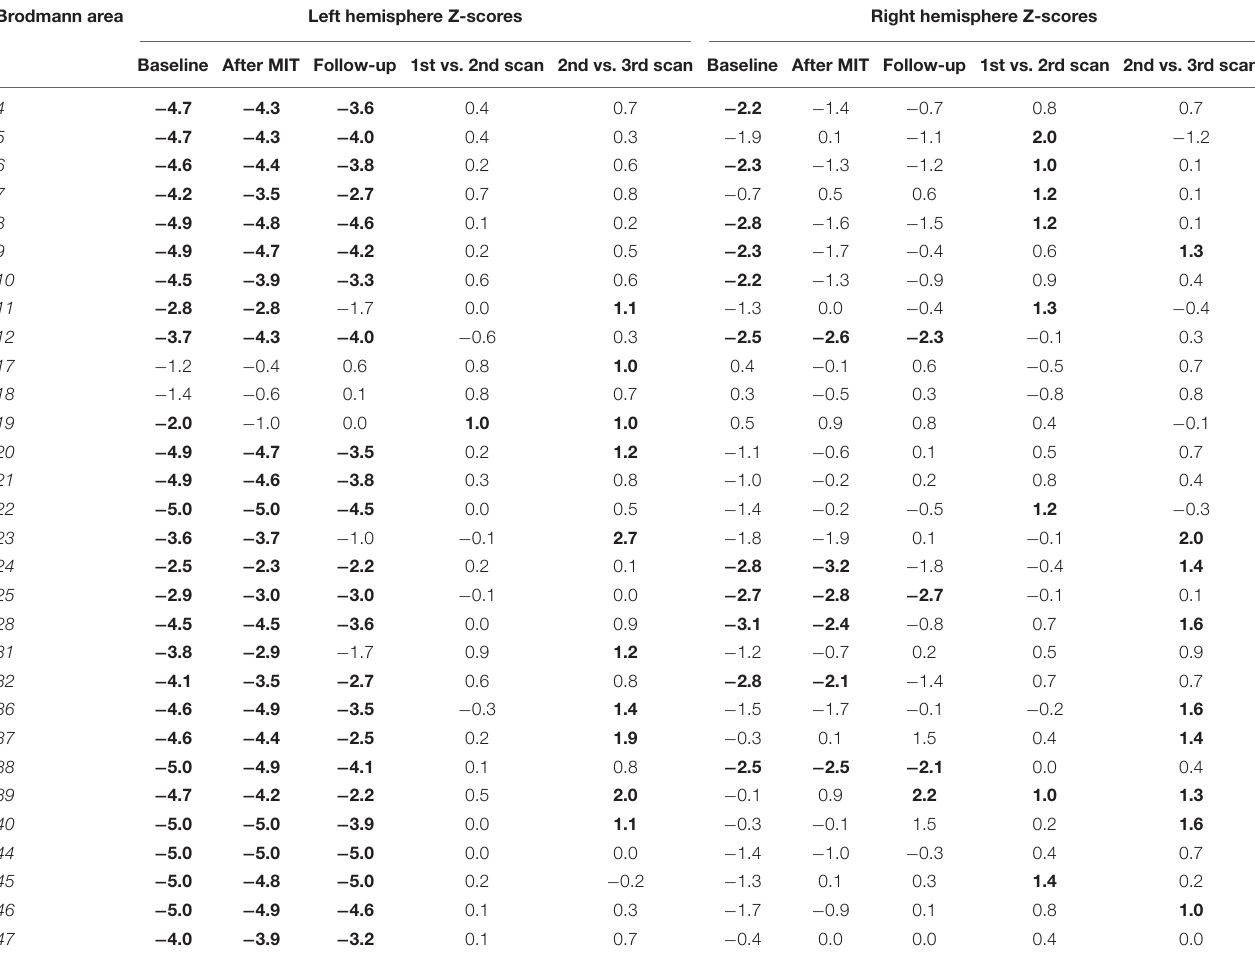
TABLE 3 | Cortical perfusion mapping of the patient compared against NeuroGam’s database of age- and gender-matched normal controls in the three time points of the study. Brodmann area Left hemisphere Z-scores Right hemisphere